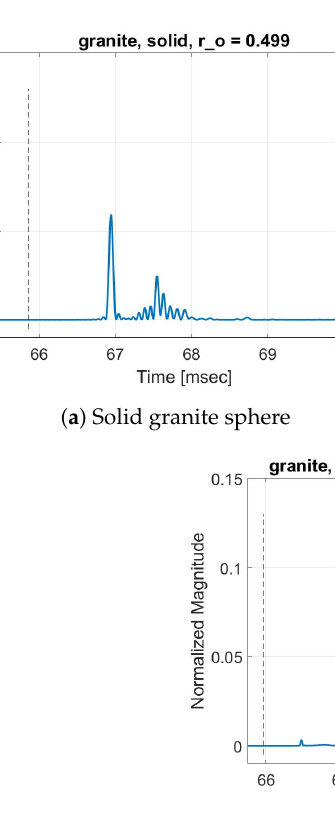
Figure 2. Simulated backscattered responses’ start and stop signal indices for the granite ( a ) sphere with a radius of 0.499 m, ( b ) shell filled with air, and ( c ) shell filled with octane oil, with an SNR level of 5 dB. The shells had an outside radius of 0.5 m and inside radius of 0.499 m. The simulated signal is shown in solid blue, and the starting and stopping indices are shown in black dashed lines. Signals have been normalized to the unit of